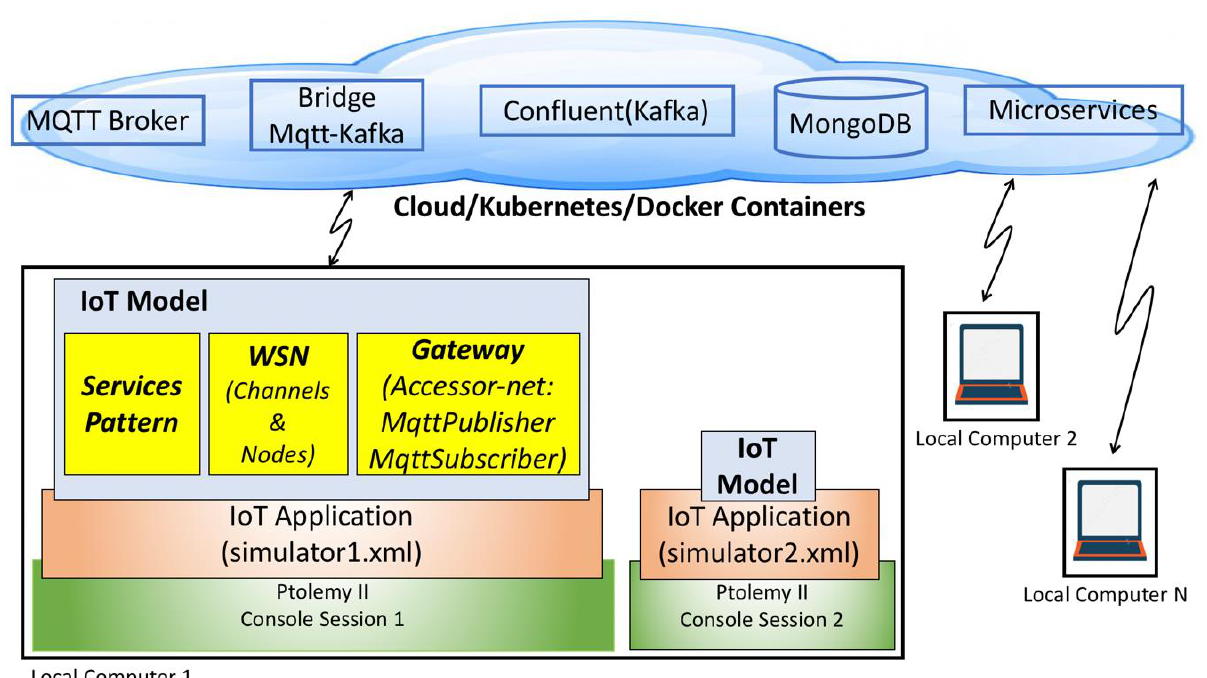
Figure 1. Modeling and simulation architecture for IoT applications in a smart city.